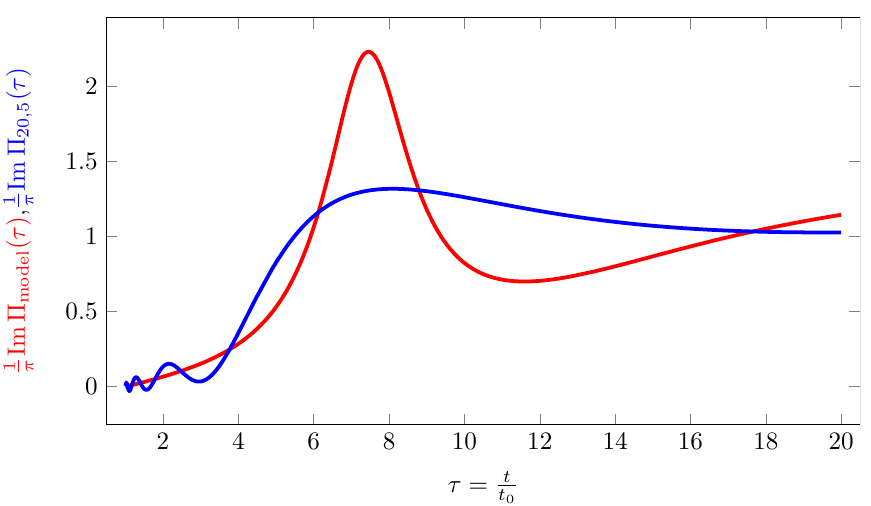
Figure 8 . “Equivalent” spectral function approximant in blue, for N=20 and L=5. In red the model spectral